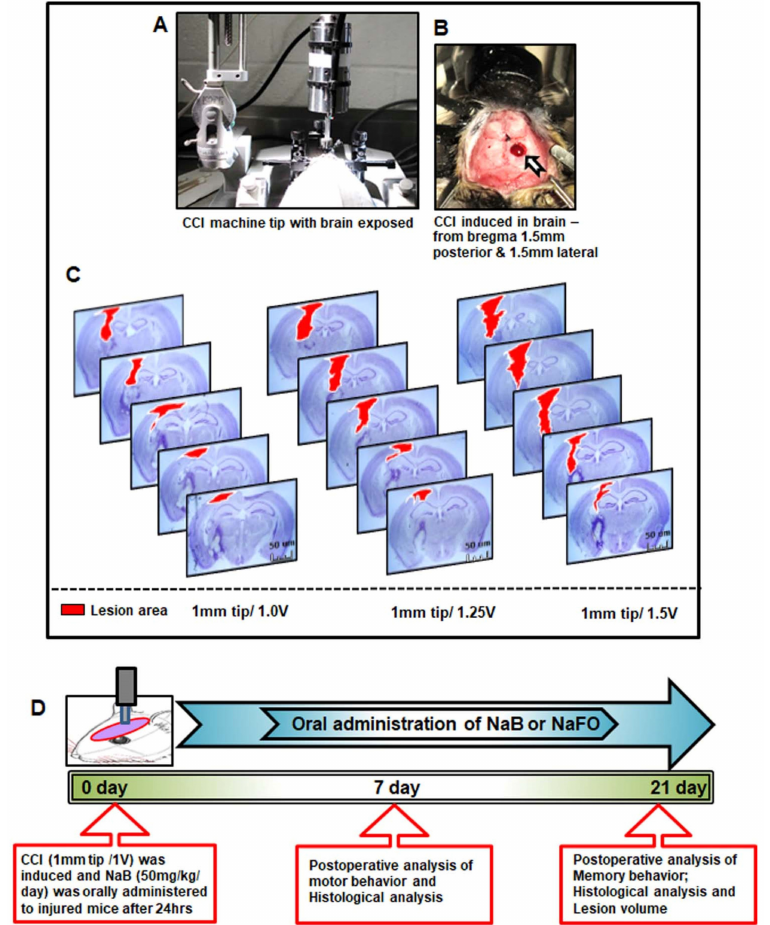
Figure 1. Standardization of CCI injury parameters and schematic presentation of experiments. ( A ) Using the CCI technique, brain injury was gently induced onto the exposed brain region of anesthetized mice. In ( B ), blood clots and tissue damage in a burr hole (stereotactic coordinates— from bregma 1.5 mm posterior and 1.5 mm lateral) were seen in the injured brain region of mice after CCI injury. ( C ) For the induction of mild, moderate and severe CCI injury, we used a 1 mm tip with three different velocities (V), viz., 1.0 V, 1.25 V and 1.5 V, respectively. After one week post-injury, mice (n = 3) were perfused with 4% paraformaldehyde followed by removal of brains and staining of the brain sections with cresyl violet. ( D ) Experimental design showing the time course of treatment, and behavioral and histological analysis following CCI injury (1 mm tip/1.0 V). Here, the unit of V is